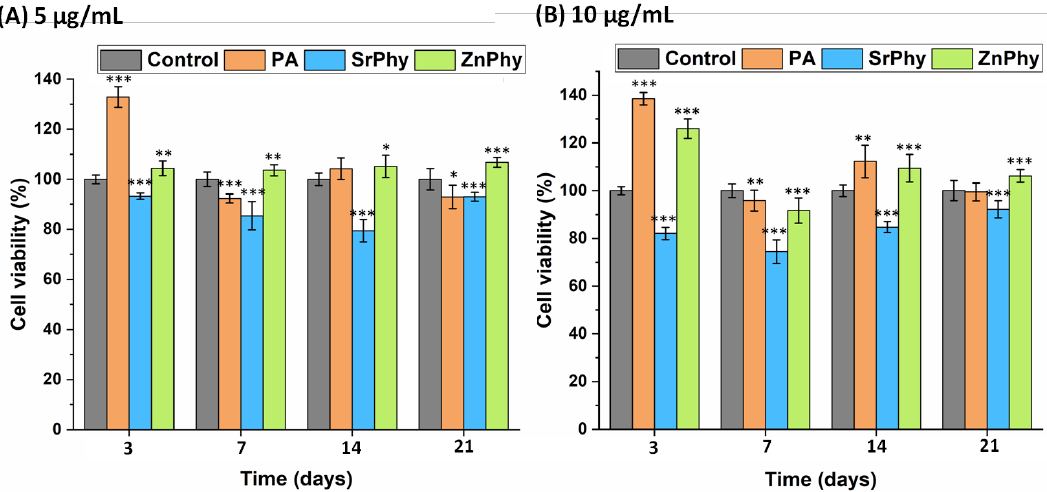
Figure 6. Metabolic activity exhibited by the hMSC cultures in the presence of PA, SrPhy and ZnPhy at ( A ) 5 µ g/mL, and ( B ) 10 µ g/mL. Cells were incubated over 3, 7, 14 and 21 days of culture. Means comparison was performed using an ANOVA analysis against the control group (basal-DMEM) for each time point (* p < 0.05, ** p < 0.005, *** p < 0.001; Tukey’s test). The results are expressed as the mean percentage value (%) ± SD ( n = 8).